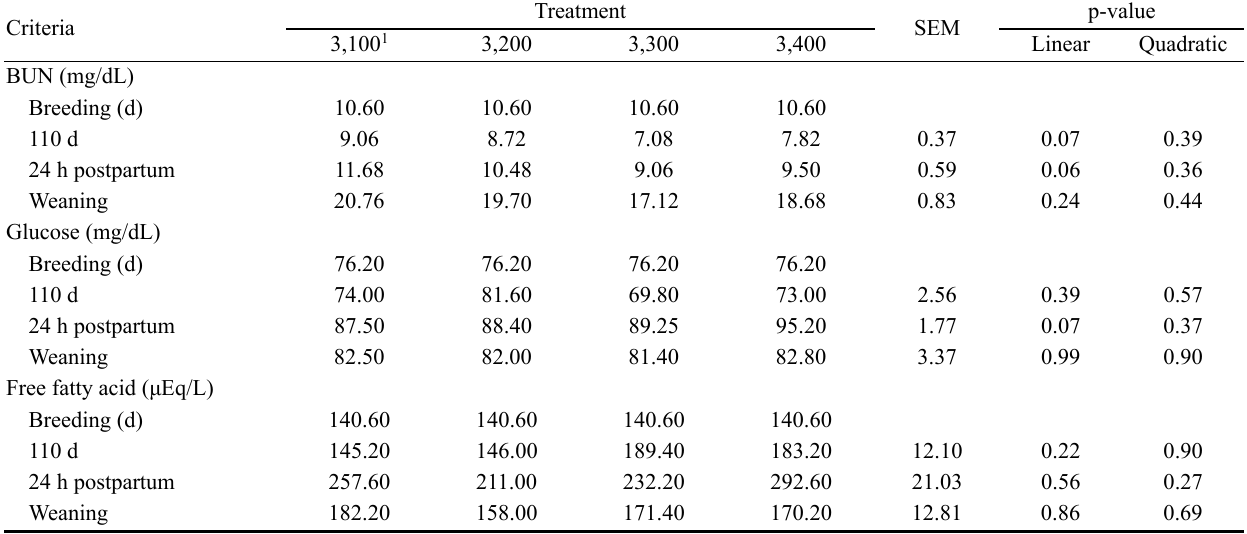
Table 7. Effects of the dietary energy level on the BUN, glucose and free fatty acid concentrations in the plasma of primiparous sows Criteria